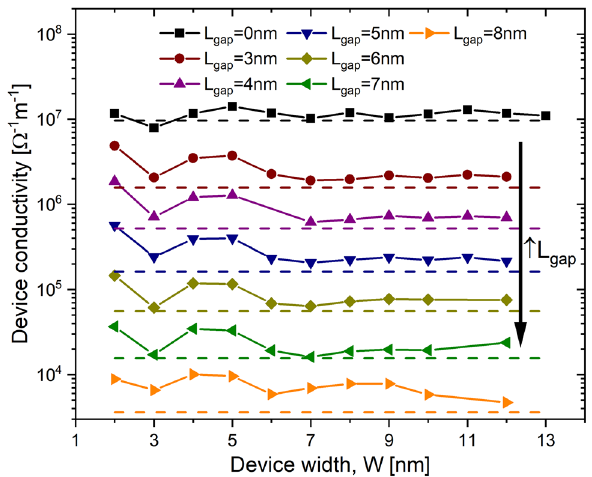
Figure 2. Conductivity for Si: P δ -layer devices. The conductivity is shown in function of the device width W for different tunnel gap lengths L gap . The corresponding conductivity values for infinitely-wide devices are indicated in dashed lines. N D of 1 mV.